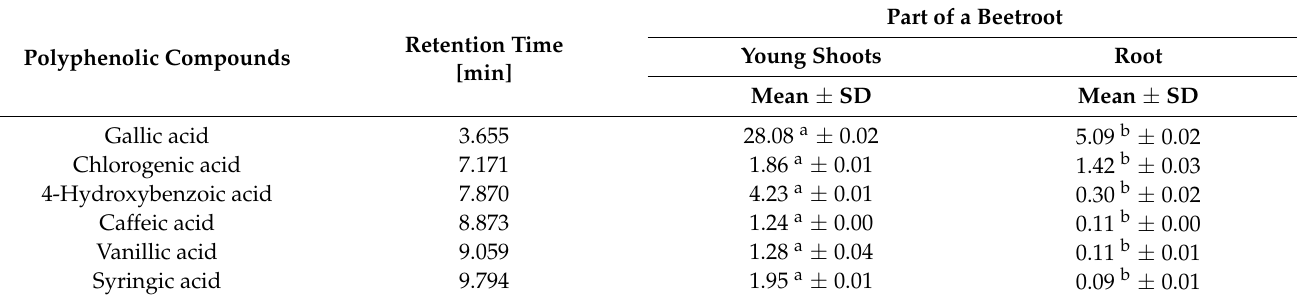
Table 1. Comparison of the contents of polyphenolic compounds in juices made from young shoots and the root of beetroot at full maturity [mg/100 mL of